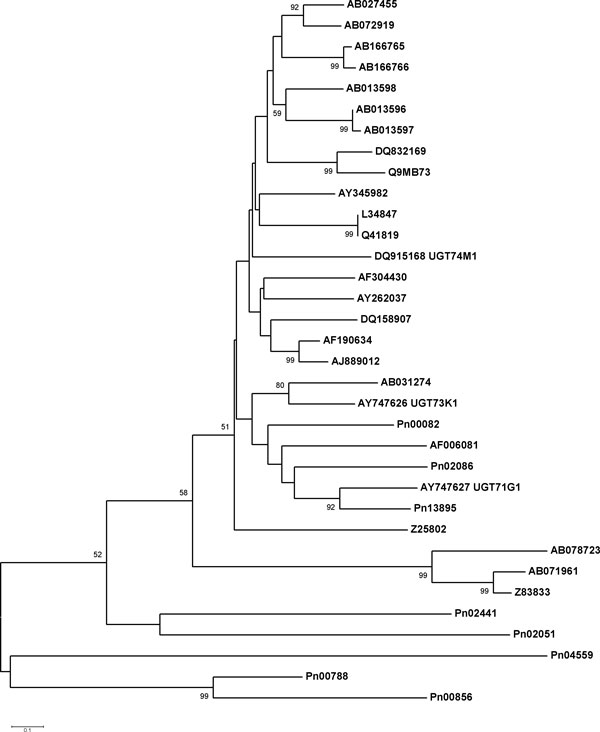
Phylogenetic analysis between full-length UGTs of P. notoginseng and characterized UGTs from other plants. Amino acid sequences were aligned using the program CLUSTALW and evolutionary distances were computed using the Poisson correction method with MEGA4. Bootstrap values obtained after 1000 replications are indicated on the branches. Values less than 50% are not shown. The GenBank/EMBL/DDBJ accession numbers of the sequences are AY747627 (Medicago truncatula), AY747626 (Medicago truncatula), DQ915168 (Vaccaria hispanica), AB013598 (Glandularia × hybrida), AB027455 (Petunia × hybrida), AB013597 (Perilla frutescens var. crispa), AB013596 (Perilla frutescens var. crispa), AY262037 (Crocus sativus), AY345982 (Stevia rebaudiana), Q41819 (Zea mays), DQ158907 (Arabidopsis thaliana), Q9MB73 (Citrus unshiu), AB166766 (Eucalyptus perriniana), AB166765 (Eucalyptus perriniana), AJ889012 (Solanum lycopersicum), AB072919 (Nicotiana tabacum), DQ832169 (Vitis labrusca), AF190634 (Nicotiana tabacum), AF304430 (Brassica napus), AB078723 (Aspergillus oryzae), Z83833 (Arabidopsis thaliana), AB071961 (Panax ginseng), AB031274 (Scutellaria baicalensis), Z25802 (Petunia × hybrida), L34847 (Zea mays).